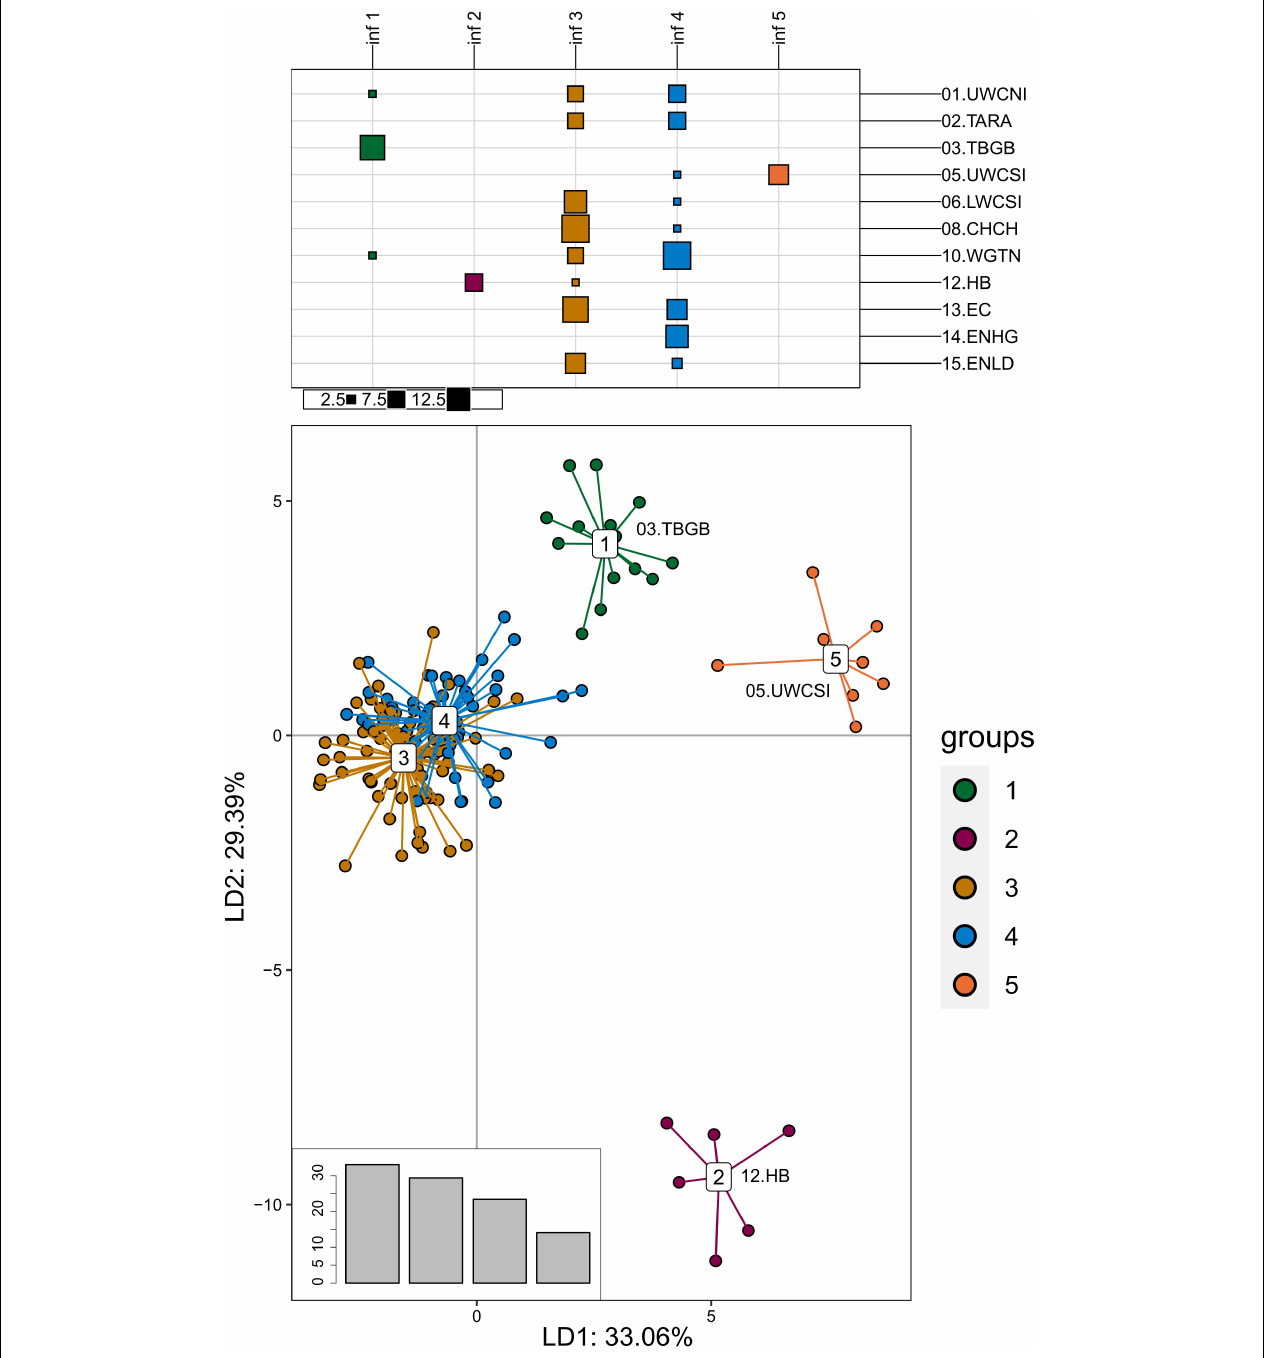
FIGURE 7 | Discriminant analysis of principal components of the second adaptive SNP dataset that include 61 loci from 140 tarakihi. Top: results of the K -means clustering analysis. All individuals were clustered into k = 5 inferred groups ( inf , in columns) based on genetic variation regardless of their sample location (rows). Size of squares corresponds to the number of individual samples. Bottom: Projection of the DAPC based on inferred groups. Bottom right: Discriminant analysis eigenvalues. Colors of groups (bottom) correspond to the inferred K-means clusters (inf 1–5, top). Sampling location codes as referred to in Table 1 .